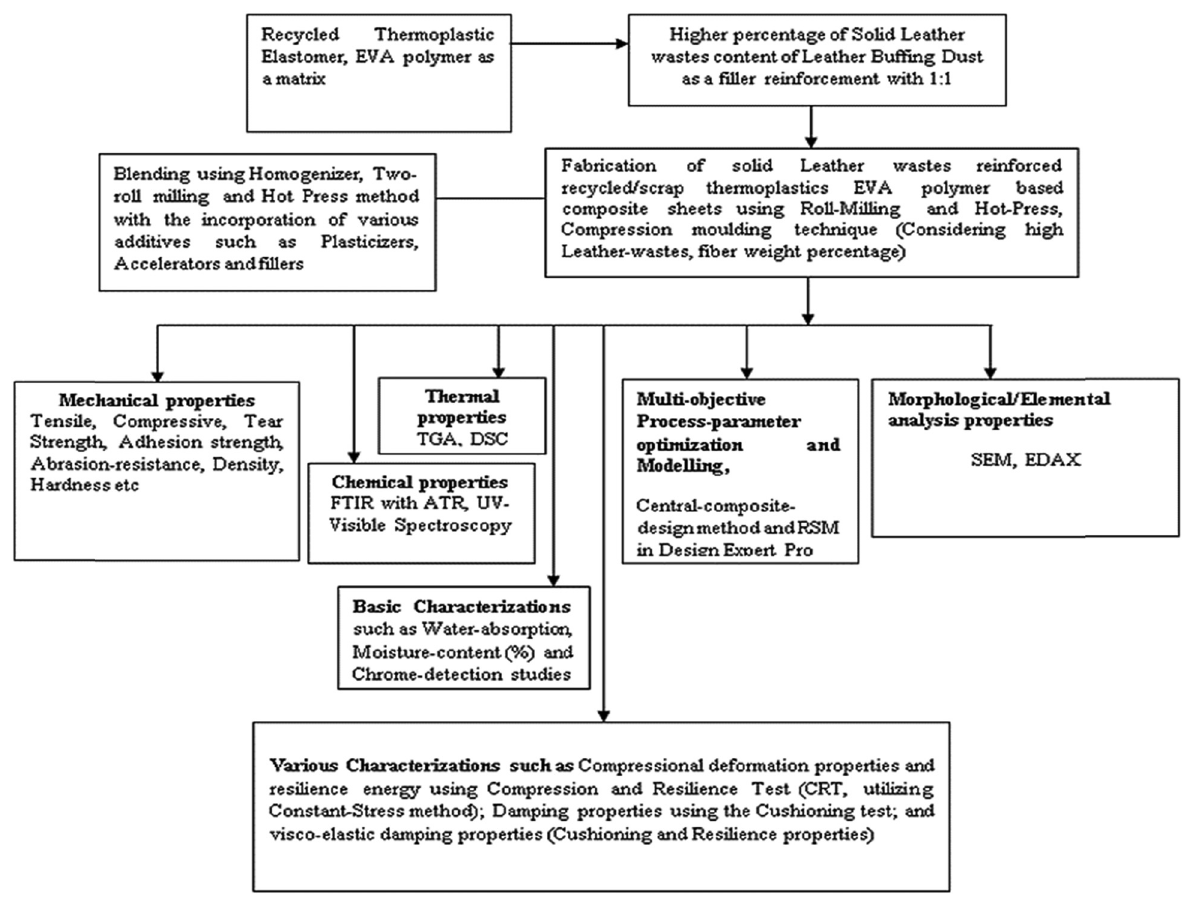
Figure 2: Research methodology was adopted in this study to achieve the set goals.